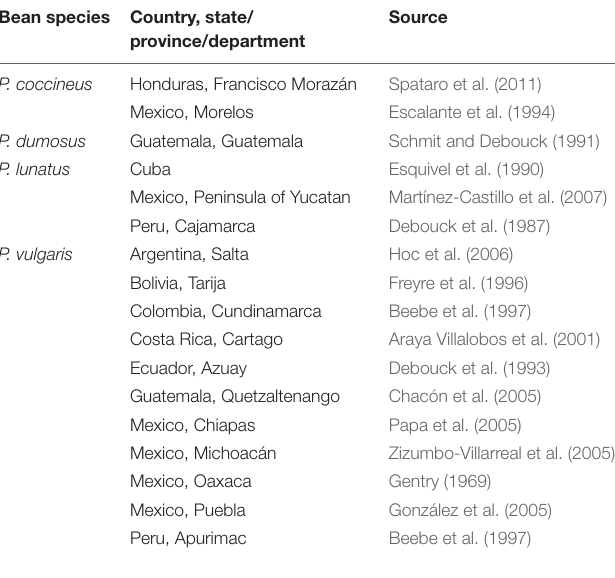
TABLE 2 | Places where weedy forms likely resulting from gene flow have been reported in the